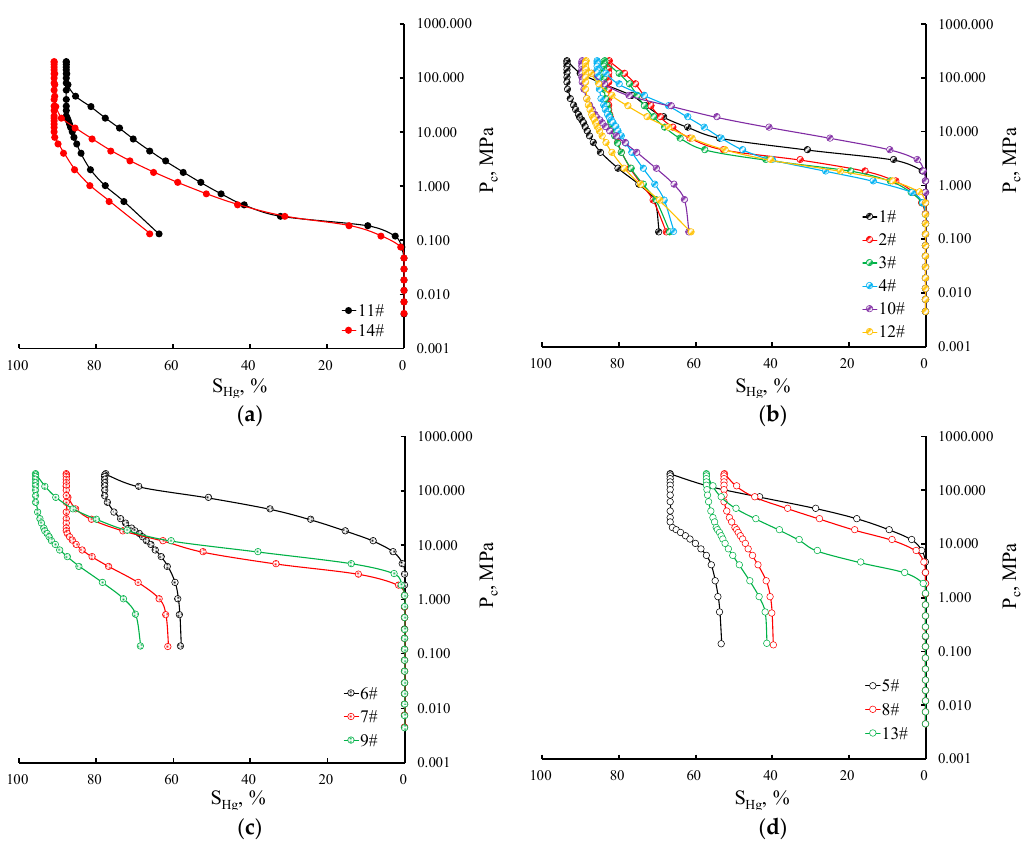
Figure 3. Comparison of four types of PCMI results: ( a ) Type α ; ( b ) type β ; ( c ) type γ ; ( d ) type δ . The gray boxes represent a partial percolation stage. Table 2. The parameters for pore structure characterization from PCMI 2